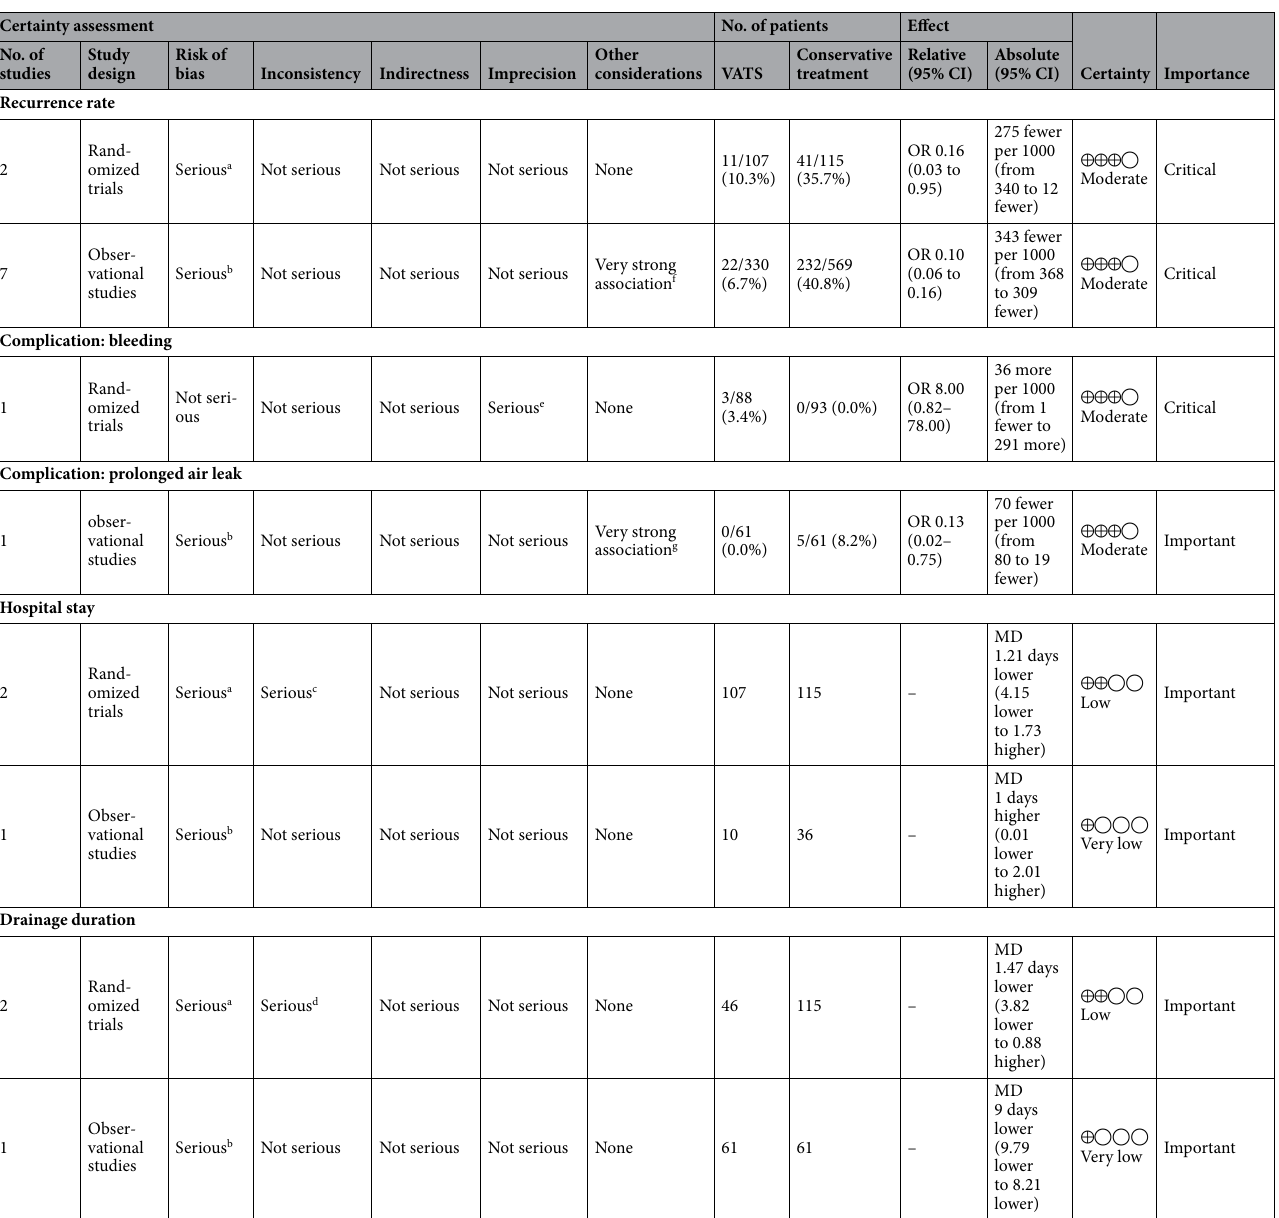
Furthermore, we suggest sharing the decision-making for patients with the first episode of PSP in order to reach the optimal personal decision, which incorporates patient preferences and values, balances both desirable and undesirable effects, and cost-effectiveness. It is crucial for clinicians to recognize that different treatment options